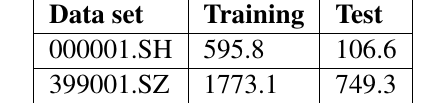
Table 4 The standard deviation of experimental data.